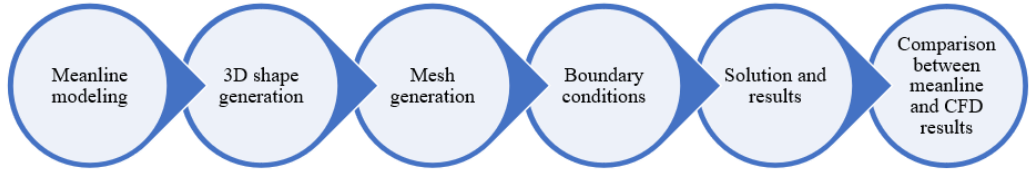
Figure 10. Flowchart of numerical analysis adopted.